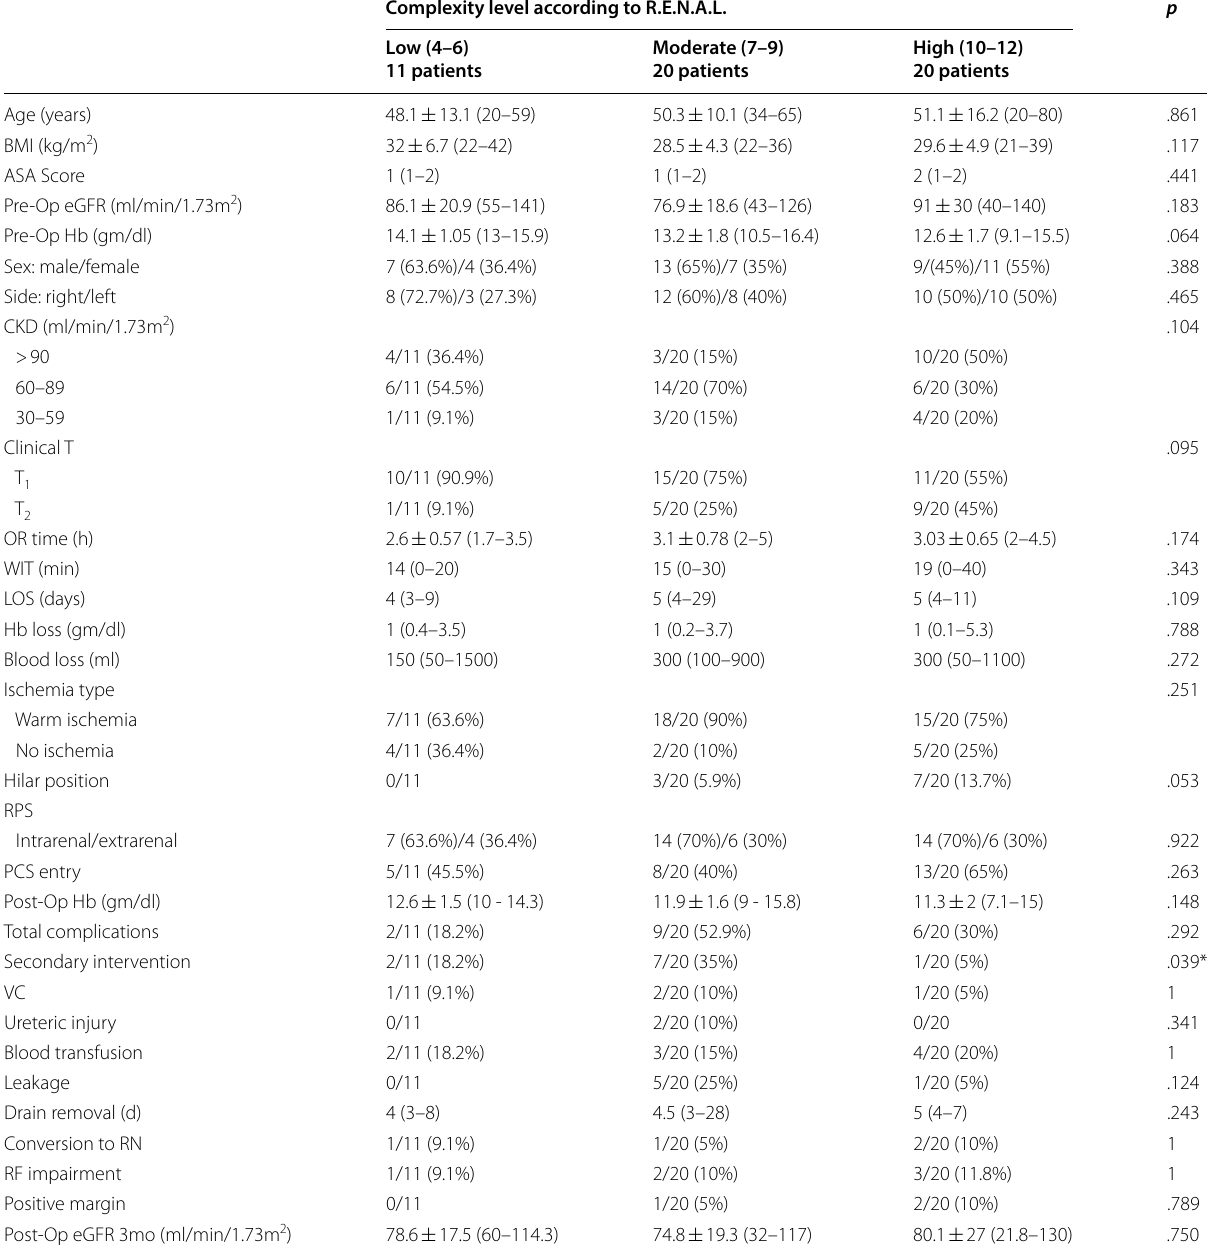
Table 3 Renal mass complexity according to R.E.N.A.L. NS in relation to outcome